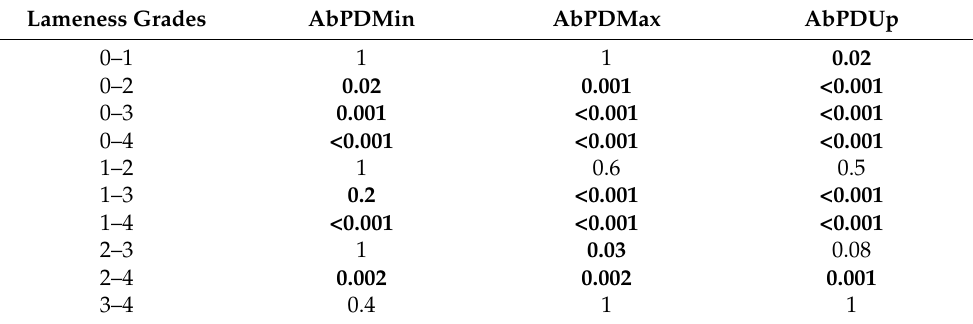
Table 1. p -values of post-hoc pairwise comparisons of lameness grades for three pelvic asymmetry measures. Values in bold highlight statistically significant results ( p < 0.05, adjusted after Bonfer- roni